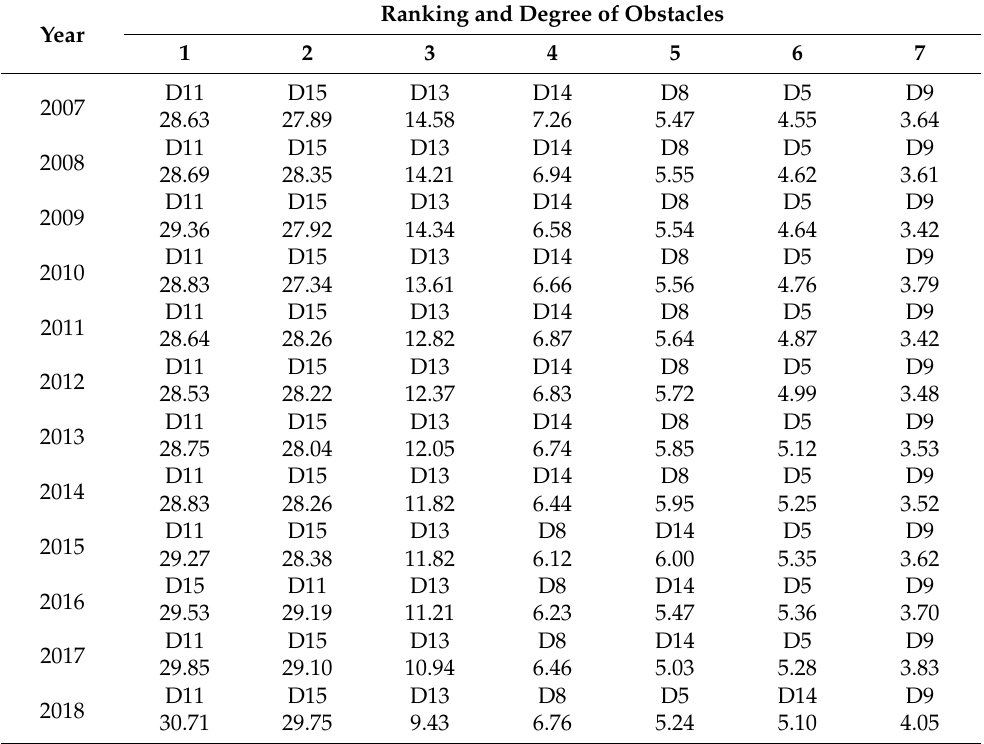
Table 5. Main obstacle indicators of LES in the BTH region from 2007 to 2018